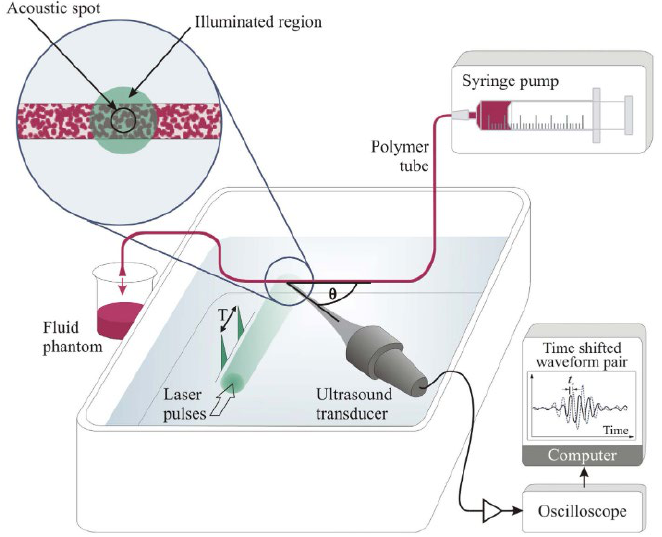
Figure 3. Experimental setup for pulsed photoacoustic Doppler flow measurement. Reprinted from Brunker et al., Sci. Rep., 2016, 6, 1: 20902 [23], with permission of Springer Nature.